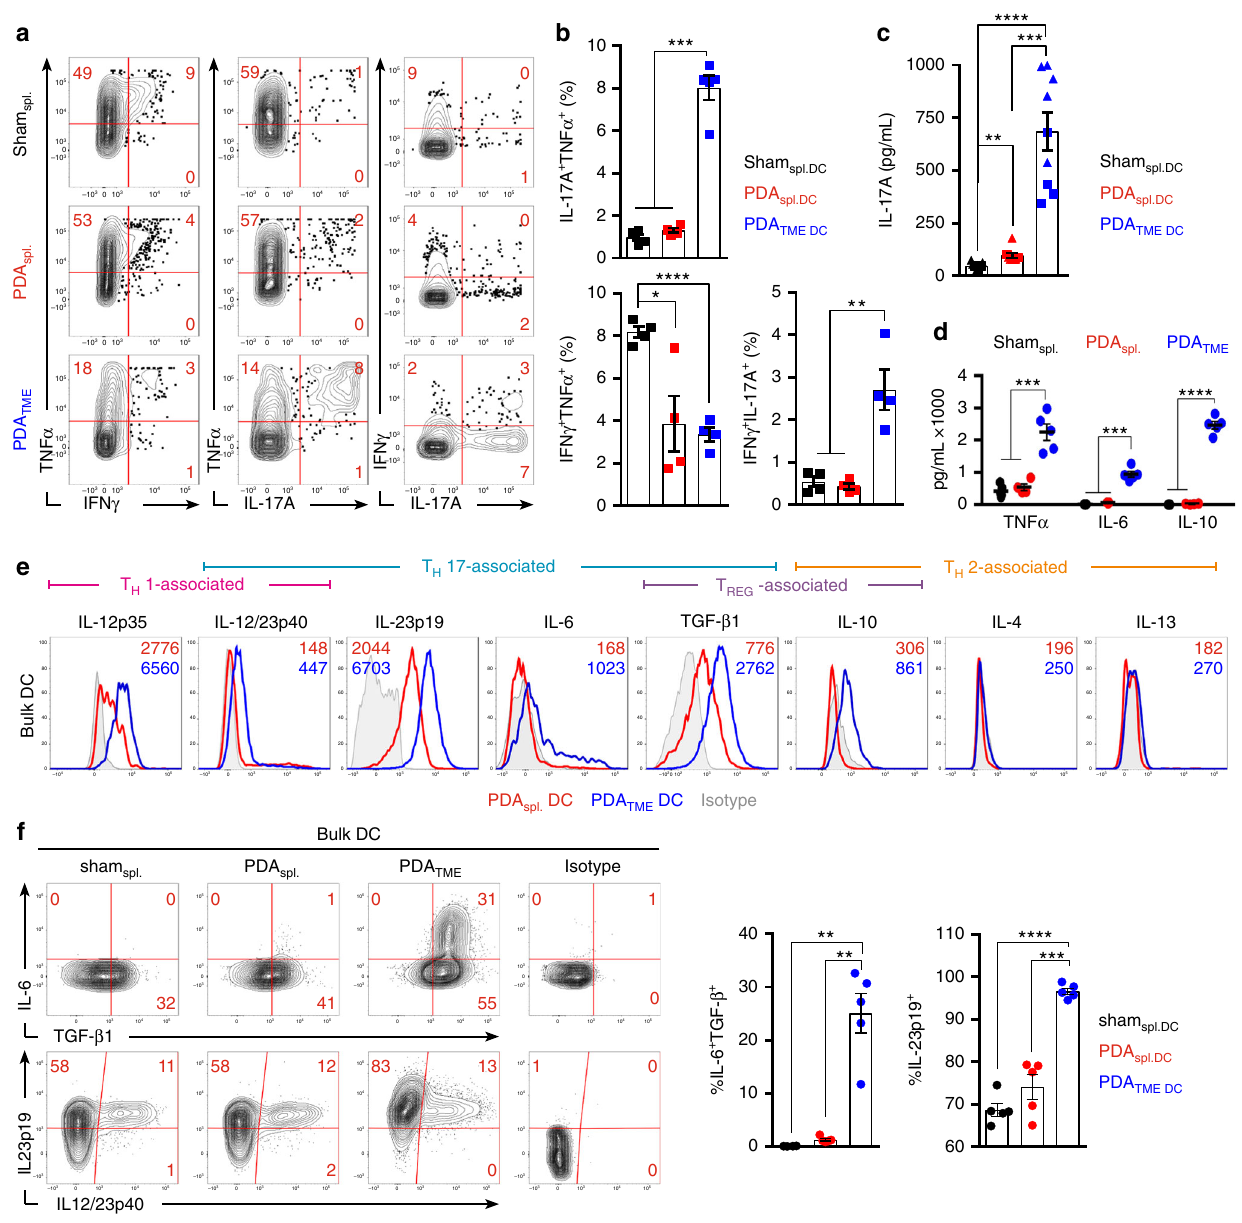
Fig. 2 PDA TME dendritic cell (DC) exhibit a unique cytokine pro fi le and promote IL-17 expression in naive CD4 + T cells. a – c Ova 323 – 339 peptide-pulsed PDA TME DC and splenic DC controls were co-cultured with Ova-restricted CD4 + T cells at a 1:5 ratio for 5 days. Representative ( a ) and quantitative ( b ) intracellular cytokine expression in the CD4 + T cells are shown. Data are representative of fi ve independent experiments using 3 – 6 mice per arm, showing similar results. c Concentration of IL-17A in the supernatants of co-cultures were determined. Squares and triangles denote data points from individual mice, pooled from two independent experiments. d PDA TME DC and splenic DC controls were plated at a density of 5 × 10 5 cells/ml without re- stimulation and supernatant cytokine concentrations were determined after 36 h in a cytometric bead array. Data are representative of experiments repeated >3 times. e Orthotopic pancreatic ductal adenocarcinoma (PDA) tumors and spleens were harvested from mice on day 25 post-implantation. Intracellular fl ow cytometric analysis of DC cytokine expression after 12 h of re-stimulation with LPS (1 μ g/ml) is shown. Representative histograms are shown. Numbers represent median fl uorescence indices (MFI). Data are representative of experiments repeated >3 times. f The frequency of IL-6, TGF- β 1 and IL23p19, IL12/23p40 co-expression in PDA TME DC and splenic DC controls were tested. Representative contour plots and quantitative data are shown ( n = 5 per group). This experiment was repeated three times (* p < 0.05, ** p < 0.01, *** p < 0.001, **** p < 0.0001, t -test),